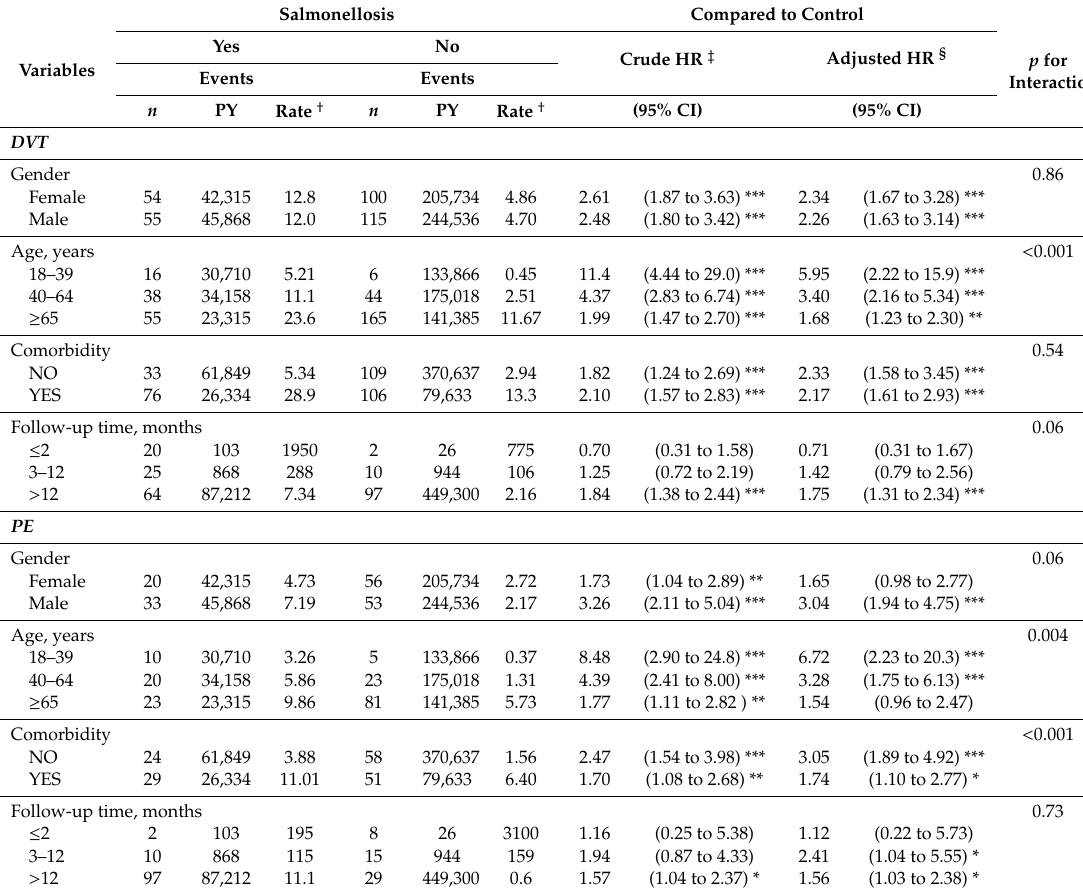
Table 3. Incidence and hazard ratios for DVT and PE among patients stratified by sex, age, and